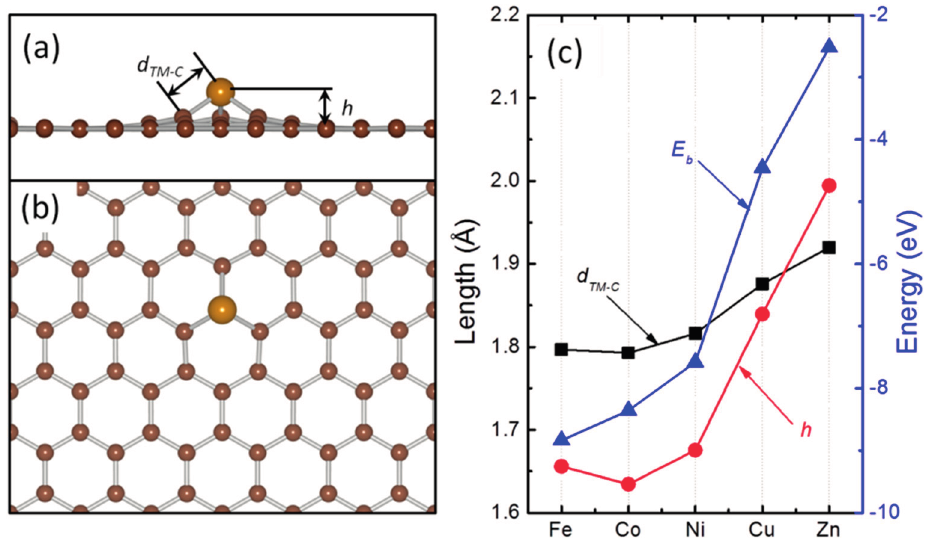
Figure 1. The side view ( a ) and top view ( b ) of the optimized structures of a TM